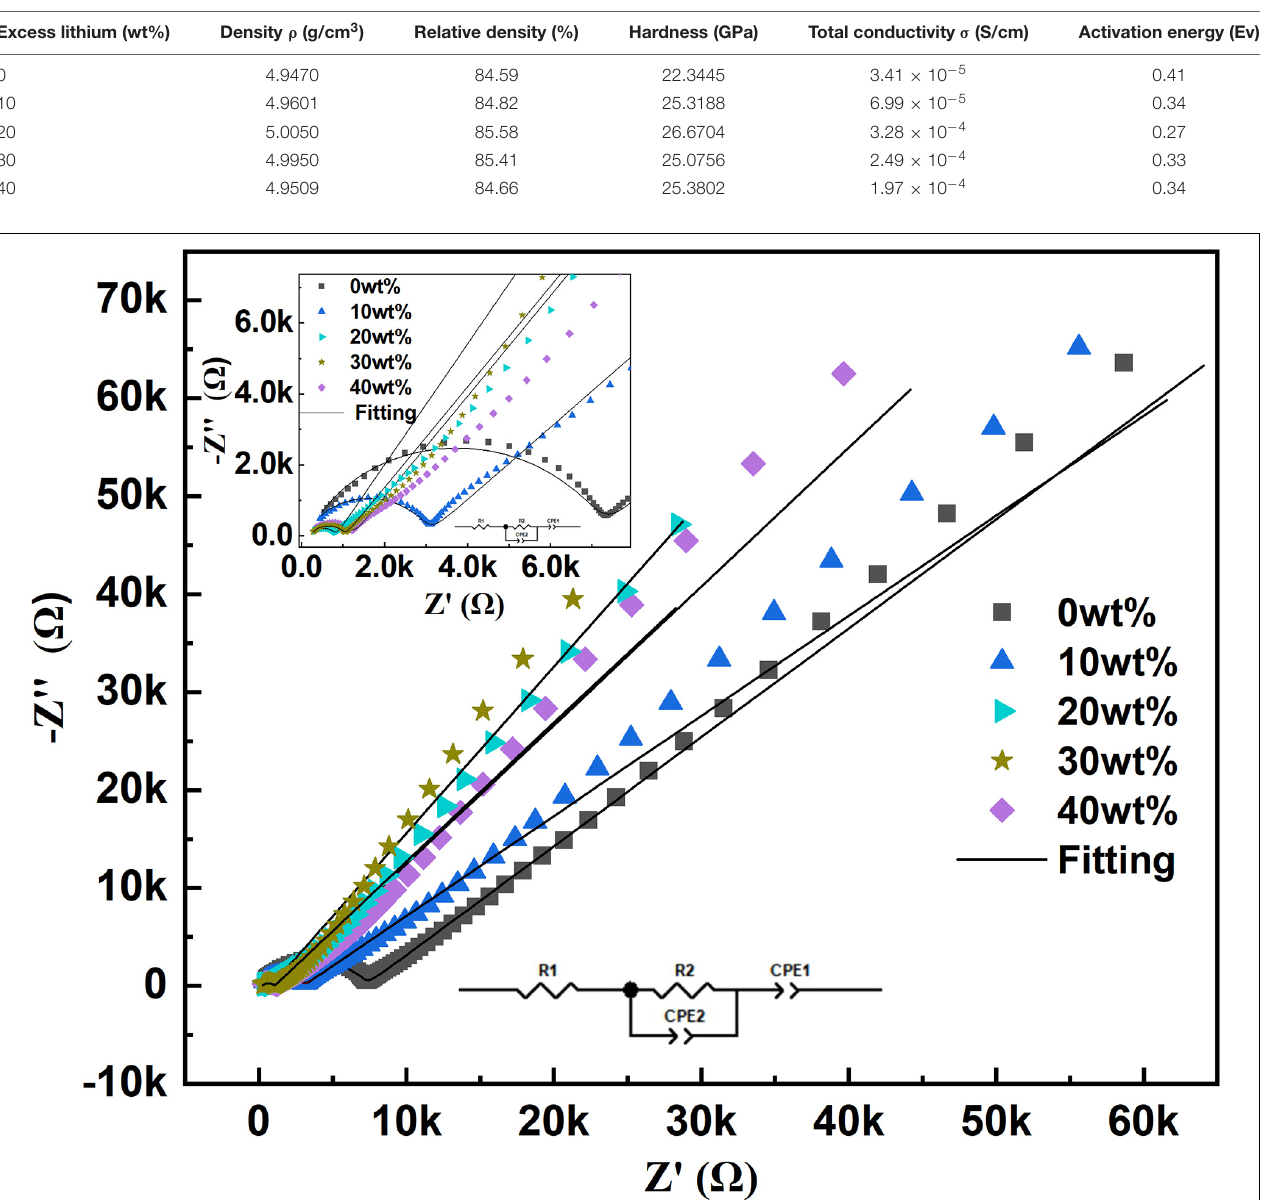
TABLE 2 | Density, surface hardness, electrical conductivity, and activation energy of LTPO with different excess lithium content.